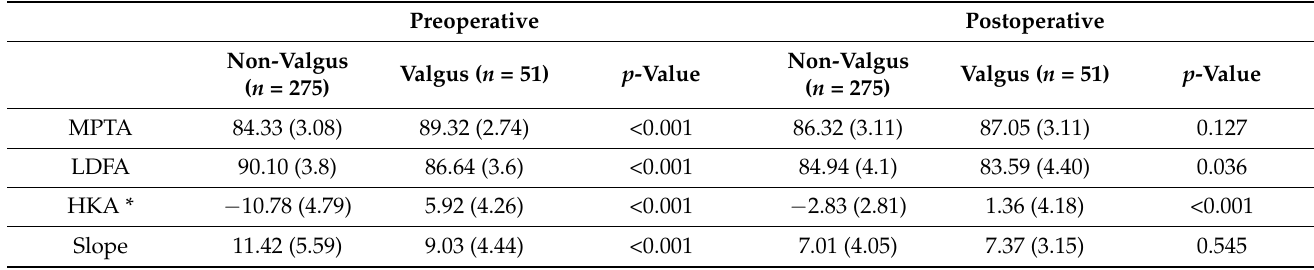
Table 2. Preoperative and postoperative alignment in the valgus and non-valgus